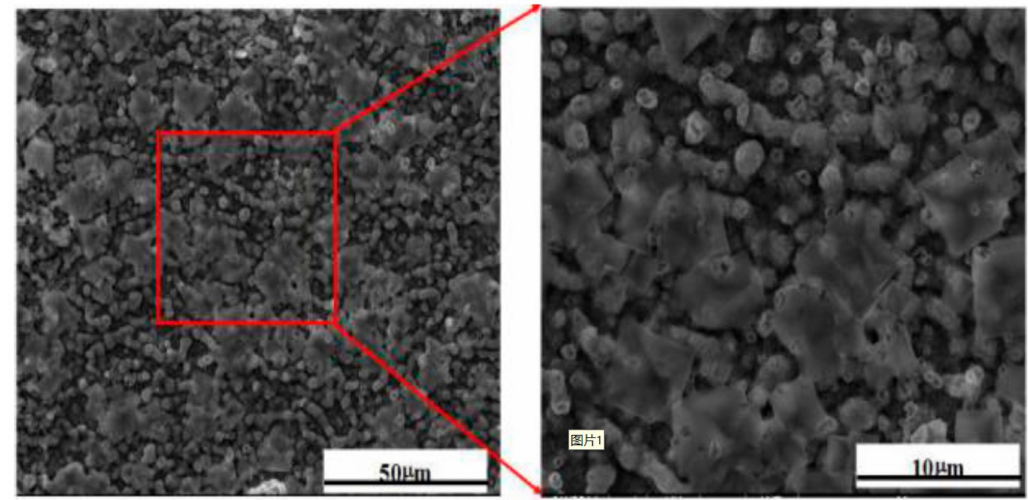
Figure 2. Surface morphology (SEM, SEI) of the NaCl deposit on the surface of the oxide scale after No. 0.5 and 1 cycles (oxidation at 900 ◦ C and emersion in 3.5% NaCl